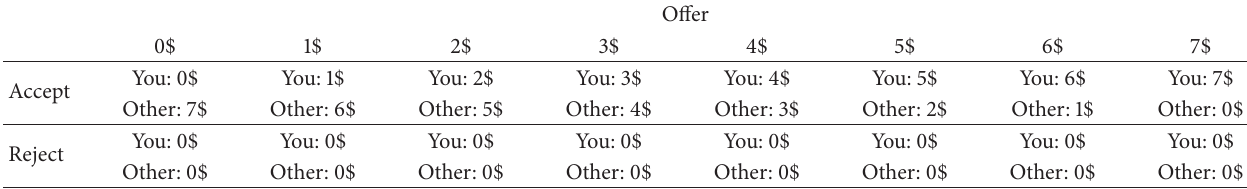
Table 3: Payoff matrix of Splitting Money